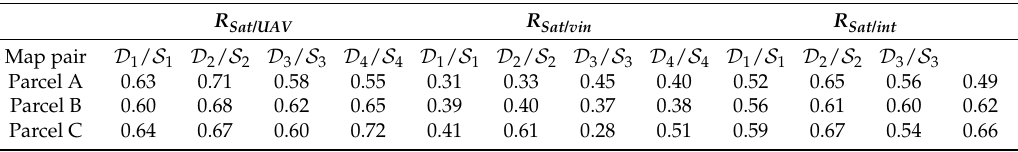
Figure 6. Scatter plots of NDVI values from NDVI sat map (x-axis) and: ( a ) the comprehensive NDVI uav map (y-axis); (b) the enhanced NDVI values of map NDVI vin (y-axis); and ( c ) the enhanced NDVI values of NDVI int map (y-axis), using imagery pair data D 2 / S 2 . The regression model and data pair correlation coefficients are also reported. Table 3. Pearson correlation coefficients results of the NDVI maps comparison procedure. R Sat / UAV R Sat / vin R Sat /